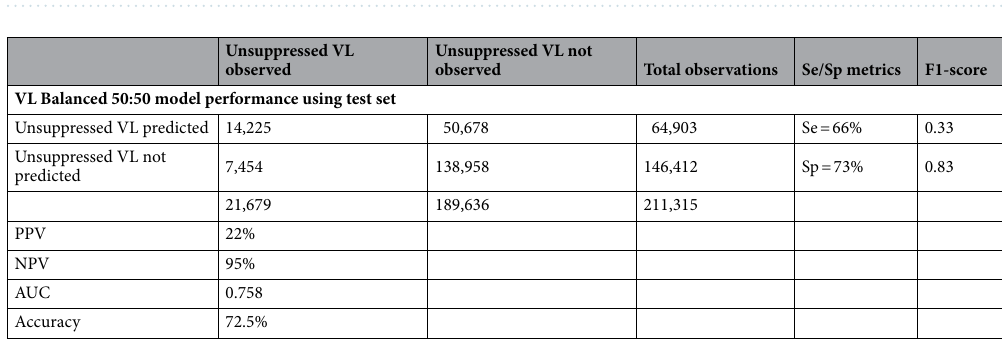
Table 3. Unsuppressed VL model metrics based on balanced (50:50) training sets. The F1 score is the harmonic mean of sensitivity and specificity such that 1.0 is the best score. Accuracy is the number of correct predictions out of the total number of predictions over the test set observations. Se = sensitivity; Sp = specificity; PPV = positive predictive value; NPV = negative predictive value.